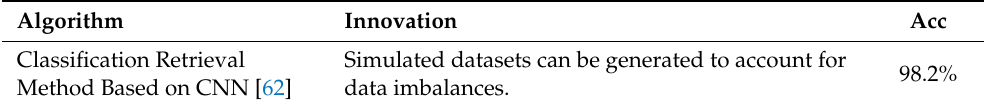
Table 3. Classification network model comparison.